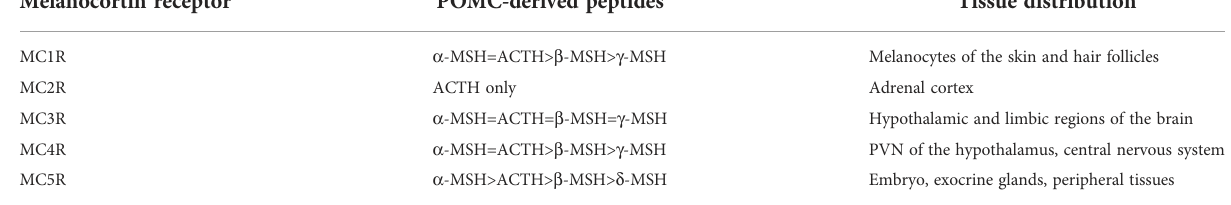
TABLE 2 Melanocortin receptors and their ligand selectivity. Melanocortin